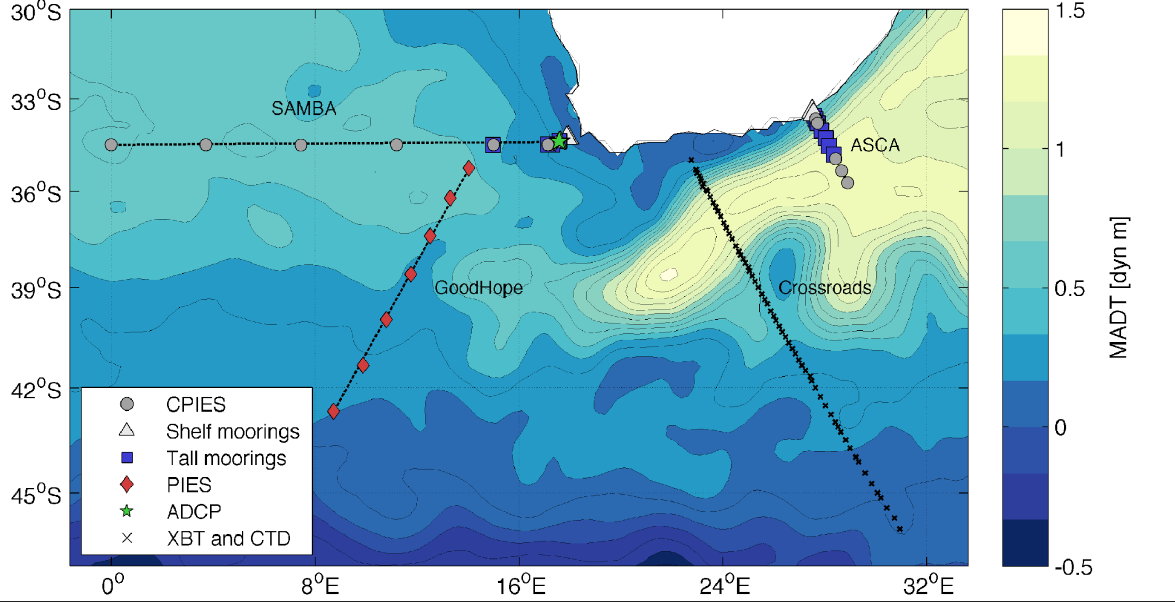
Figure 2: The four monitoring arrays and their respective instrumentation – ASCA, Crossroads, GoodHope and SAMBA – plotted on the average absolute dynamic topography for